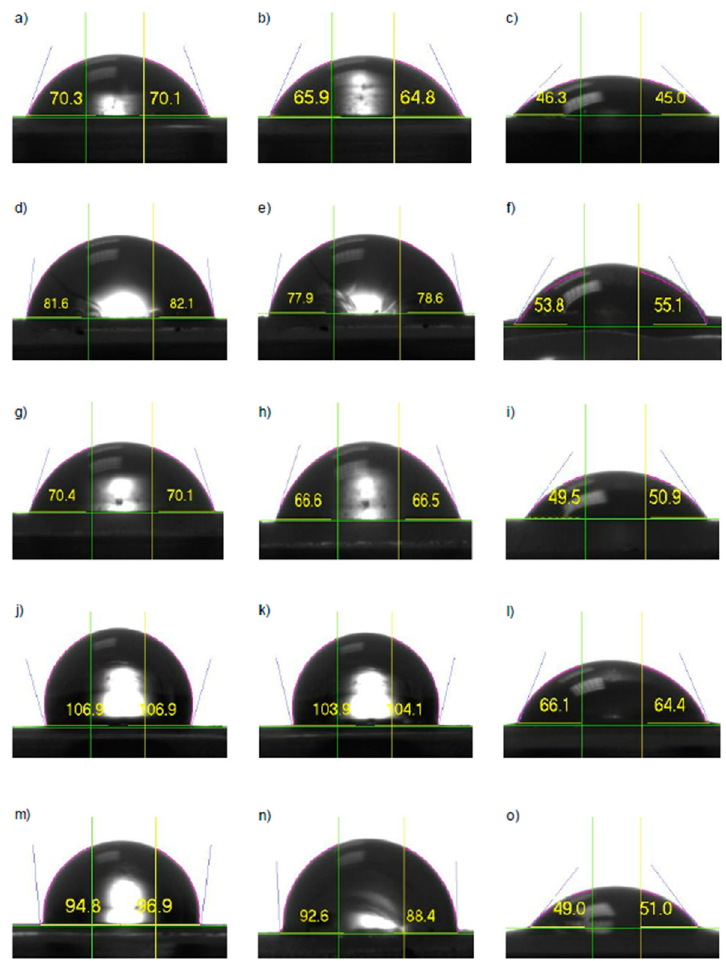
Figure 7. Water and diiodomethane contact angles of selected samples ( a ) WCA0 of neat PU; ( b ) WCA2 of neat PU; ( c ) ICA of neat PU; ( d ) WCA0 of DDA; ( e ) WCA2 of DDA; ( f ) ICA of DDA; ( g ) WCA0 of TSA; ( h ) WCA2 of TSA; ( i ) ICA of TSA; ( j ) WCA0 of OA; ( k ) WCA2 of OA; ( l ) ICA of OA; ( m ) WCA0 of Na + ; ( n ) WCA2 of Na + ; ( o ) ICA of Na + .